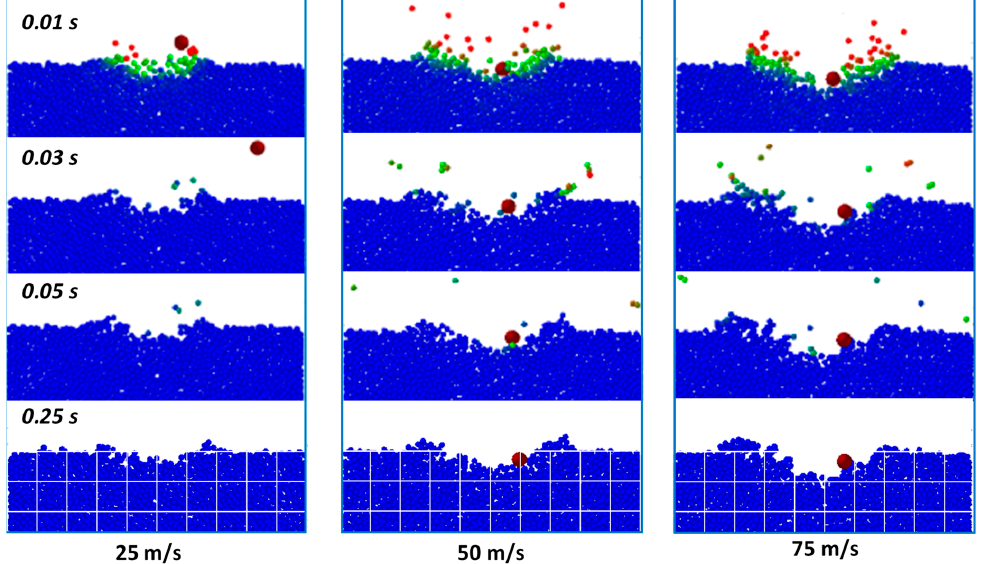
Figure 19. The process of seed penetration into medium cohesive soil at different speeds. Analysis of the data shows that at speeds of 25 m/s, the seed is ejected from the crater outside the modeling zone in all experiments. At a speed of 50 m/s, the probability of seed ejection is reduced to 10%. The depth of the crater at speeds of 50 and 75 m/s is also slightly greater than the penetration depth of the seed. Figure 20 shows color diagrams of the central cut of the soil, demonstrating the pro- cess of penetration the pelleted seed into the cohesive soil at flight speeds of 25, 50 and 75 m/s.